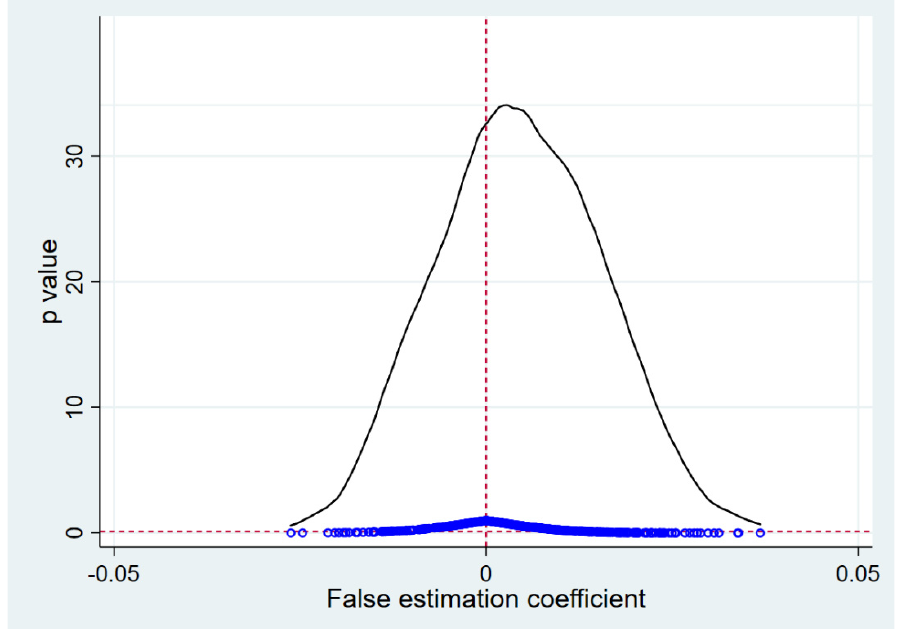
Figure 2. Placebo